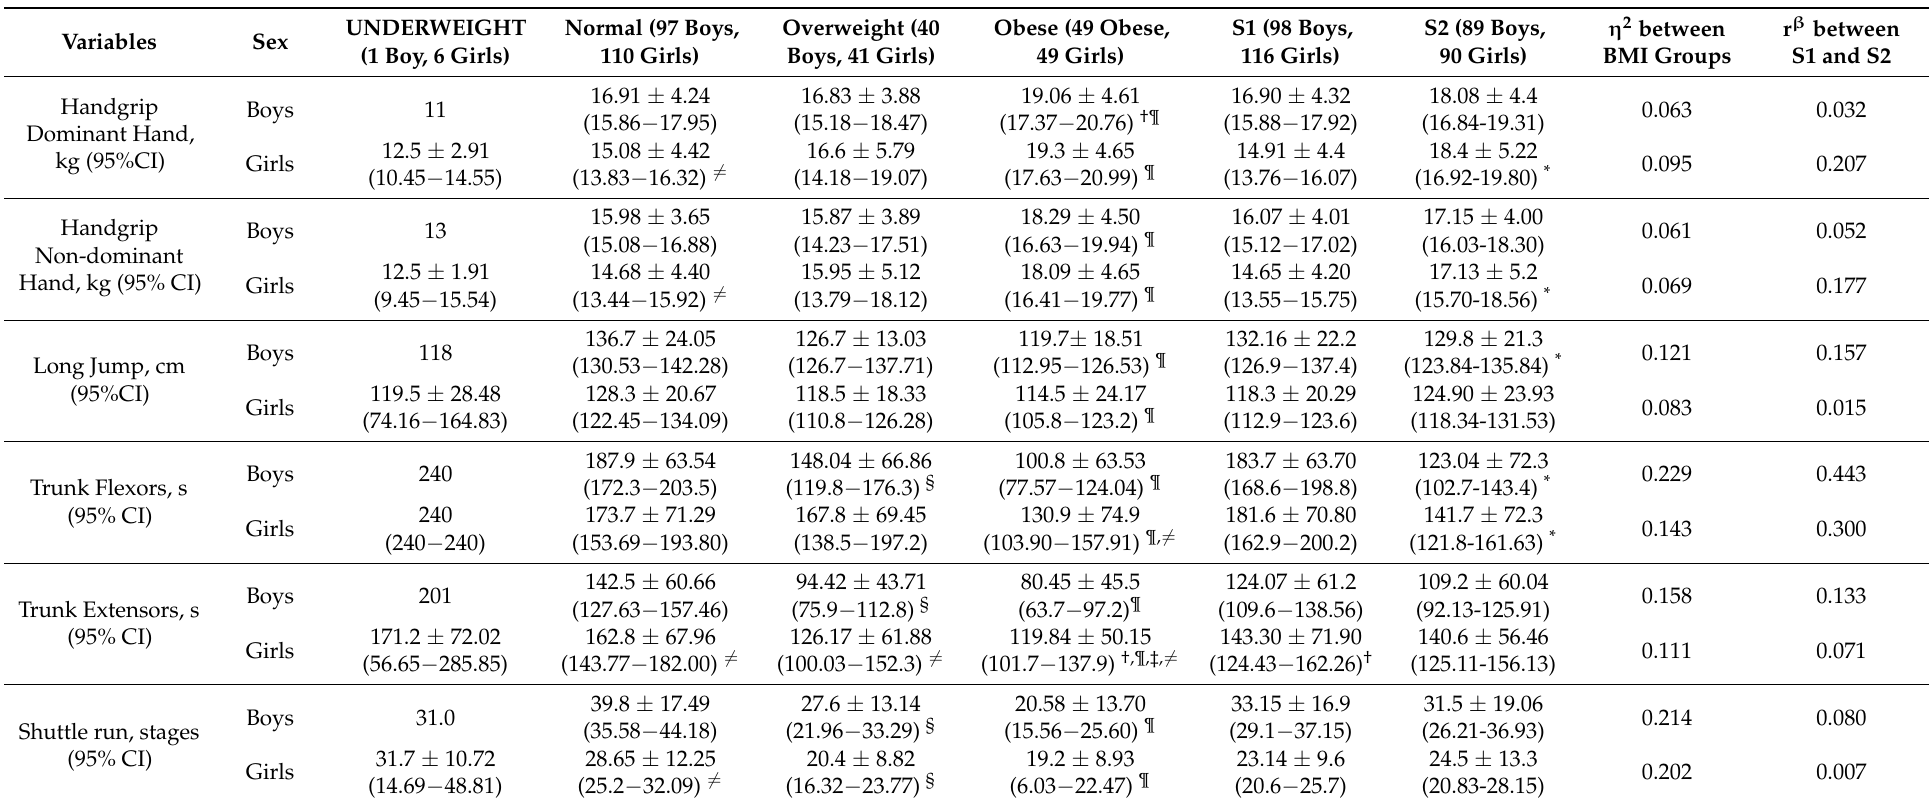
Table 2. Physical performance test across body mass index